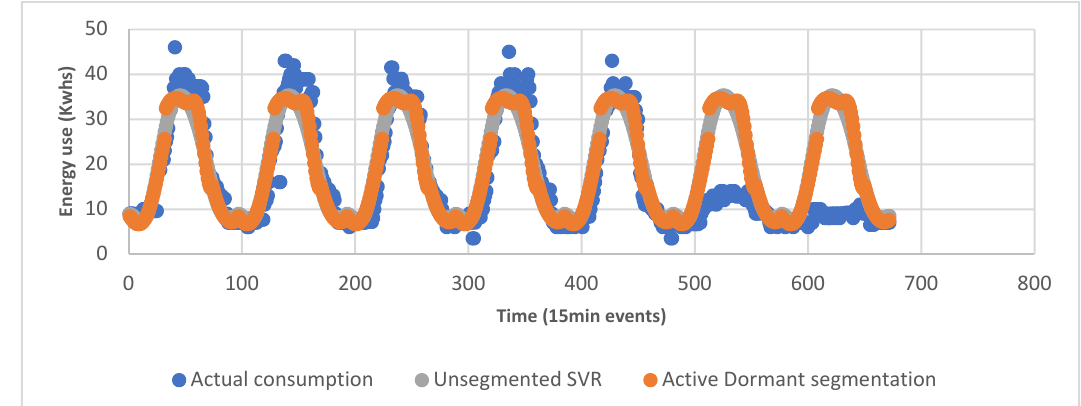
Figure A12. A comparison of weekday and weekend segmented weekly SVR prediction, to actual consumption and the unsegmented SVR predicted consumption, in the first week of autumn.